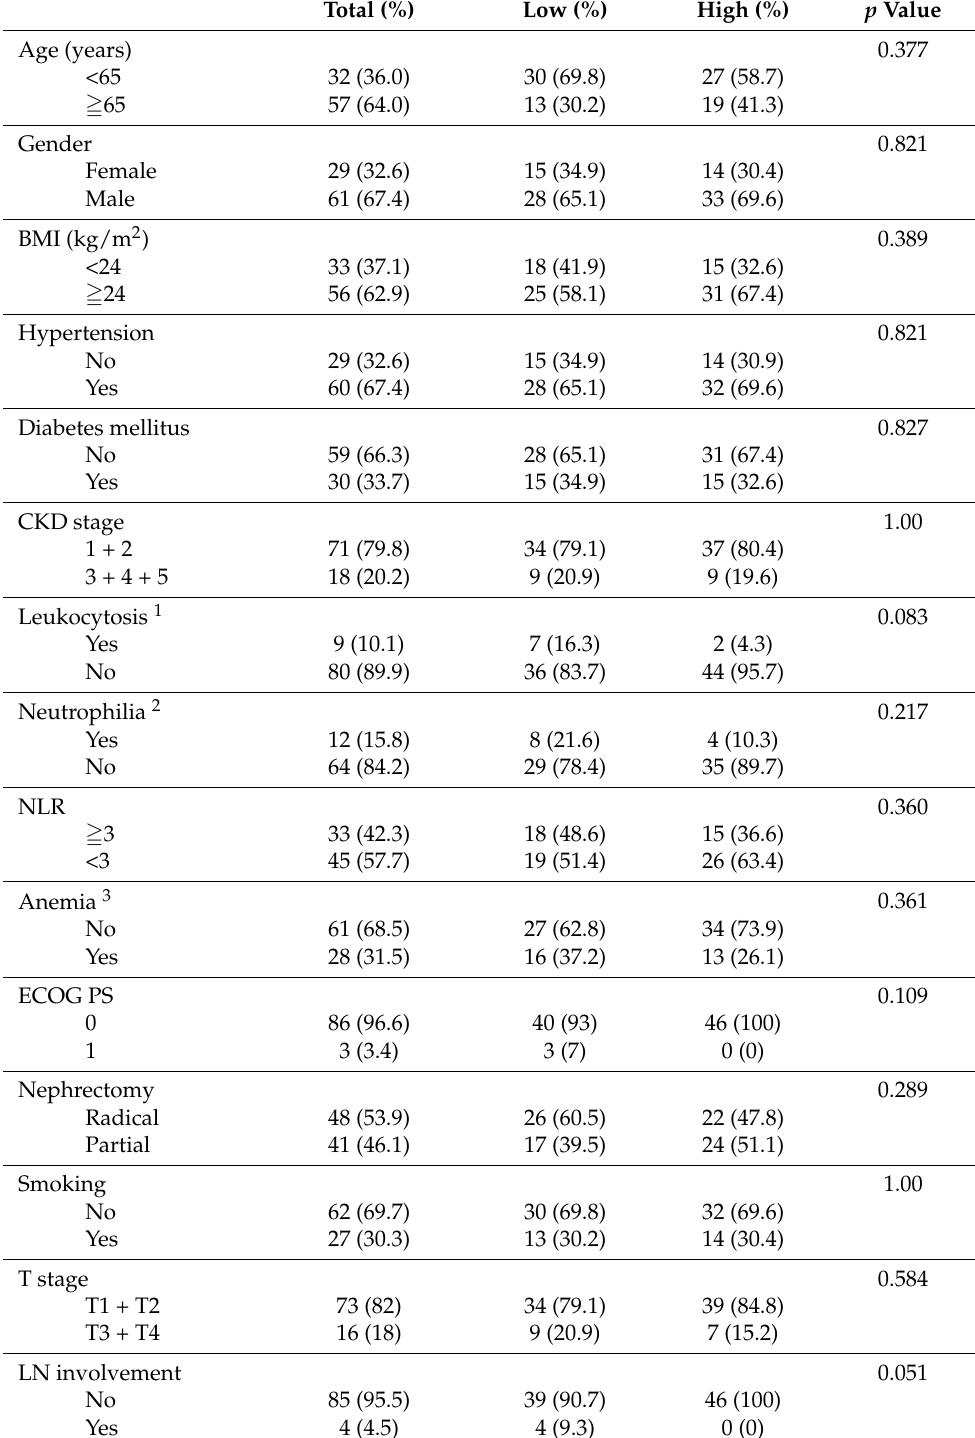
Table 1. Baseline patient characteristics and tumor characteristics of high and low MPV/PC ratio groups with a cut-off value of